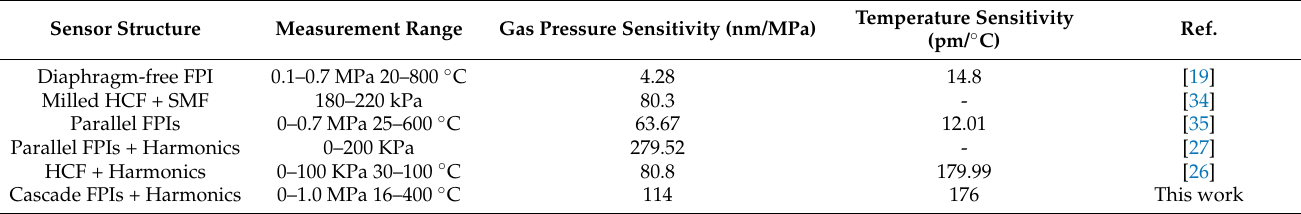
Table 3. Comparison of gas pressure sensitivity and temperature sensitivity of different optical fiber